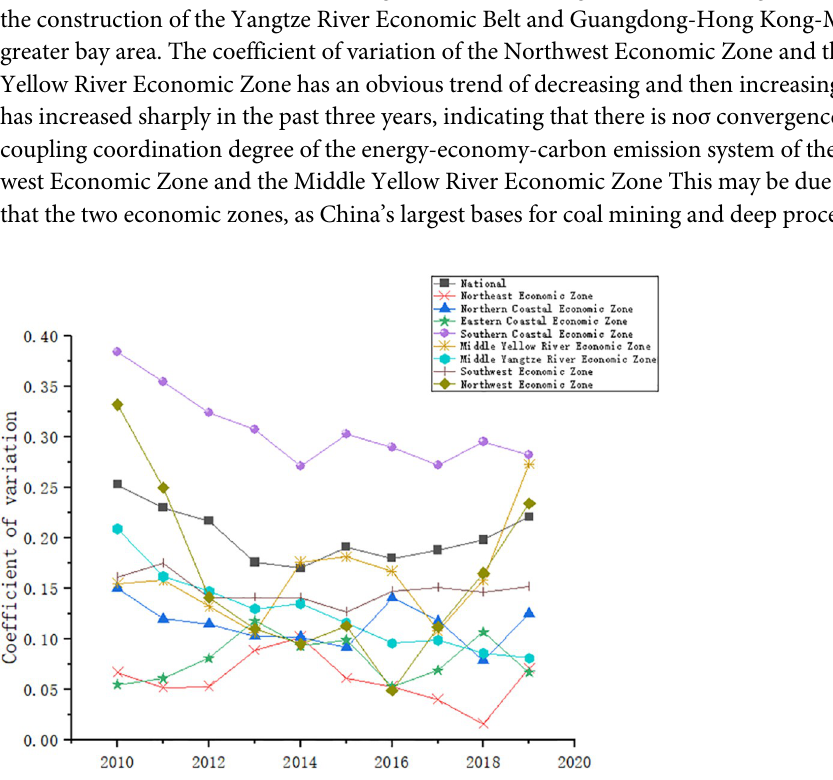
Fig 8. σ convergence of the coupling coordination degree of the energy-economy-carbon emission